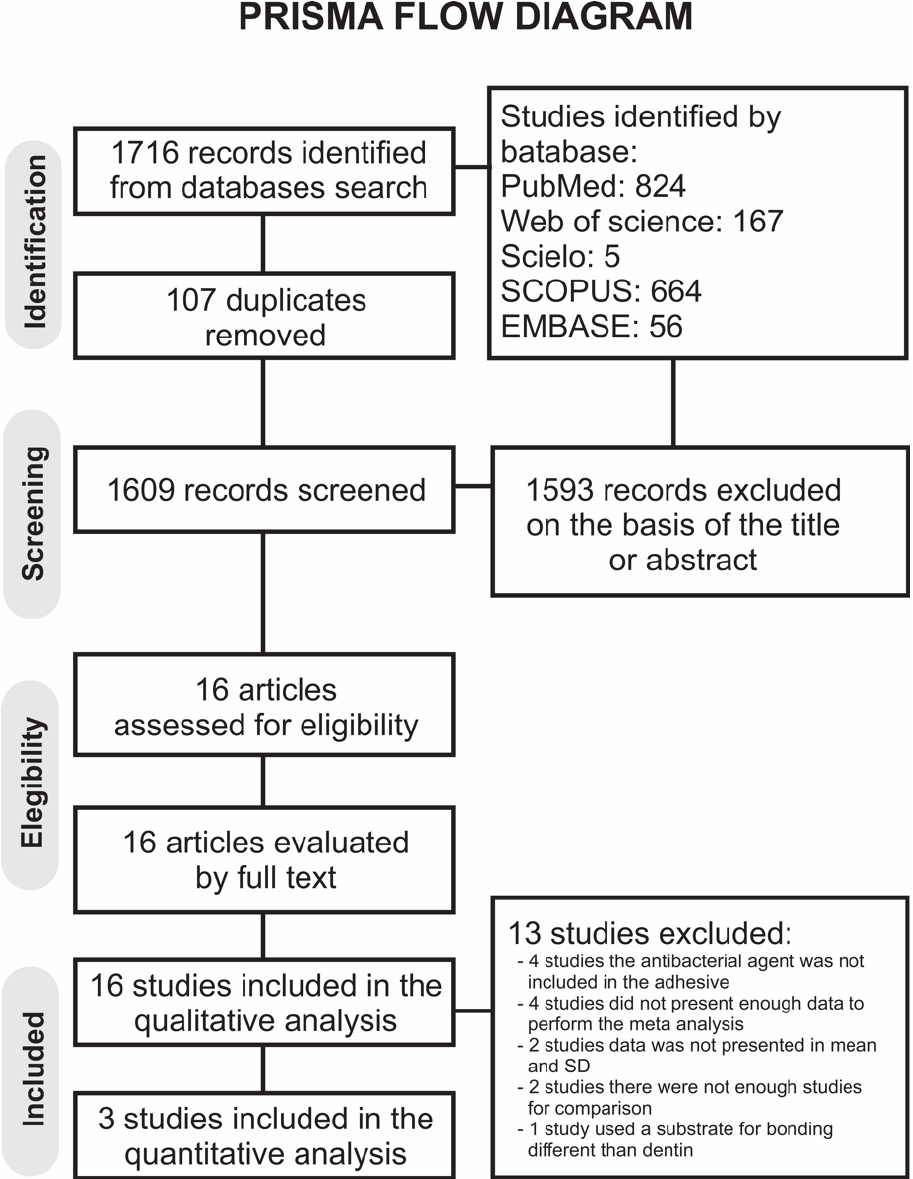
Figure 1. Prisma flow diagram of the study.